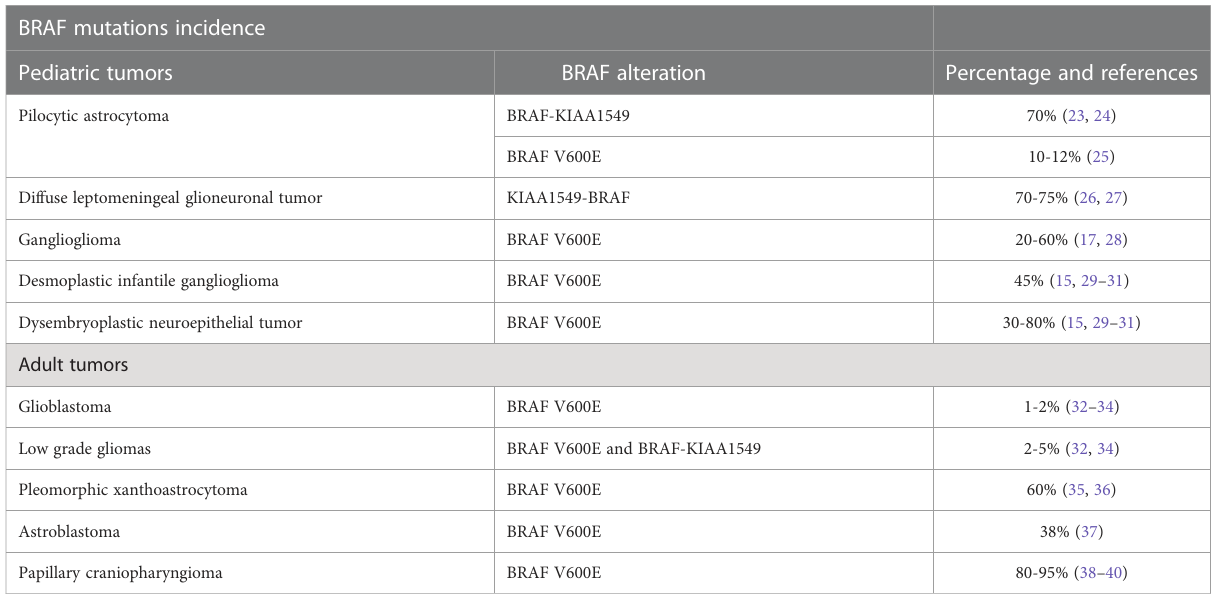
TABLE 1 Incidence and subtype of BRAF mutations within central nervous system primary tumors in pediatric and adult population. BRAF mutations